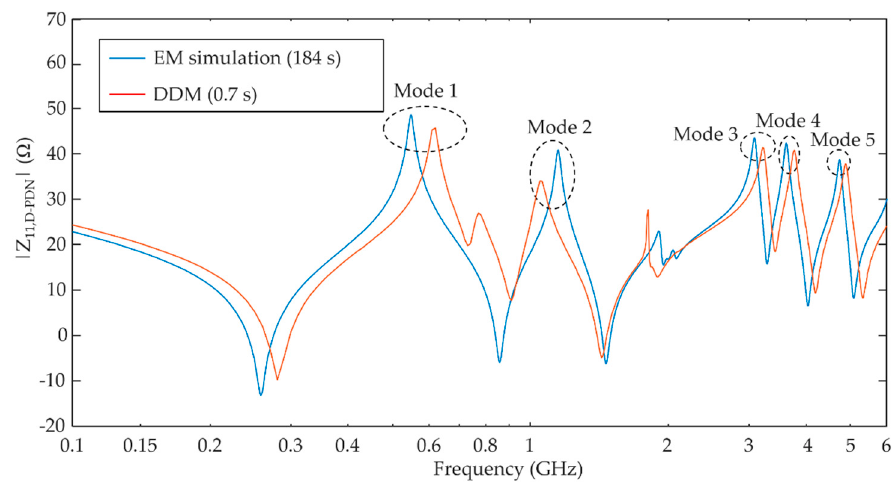
Figure 11. Self-impedances (Z 11 ) of the DGS–EBG-based PDN for power integrity analysis.